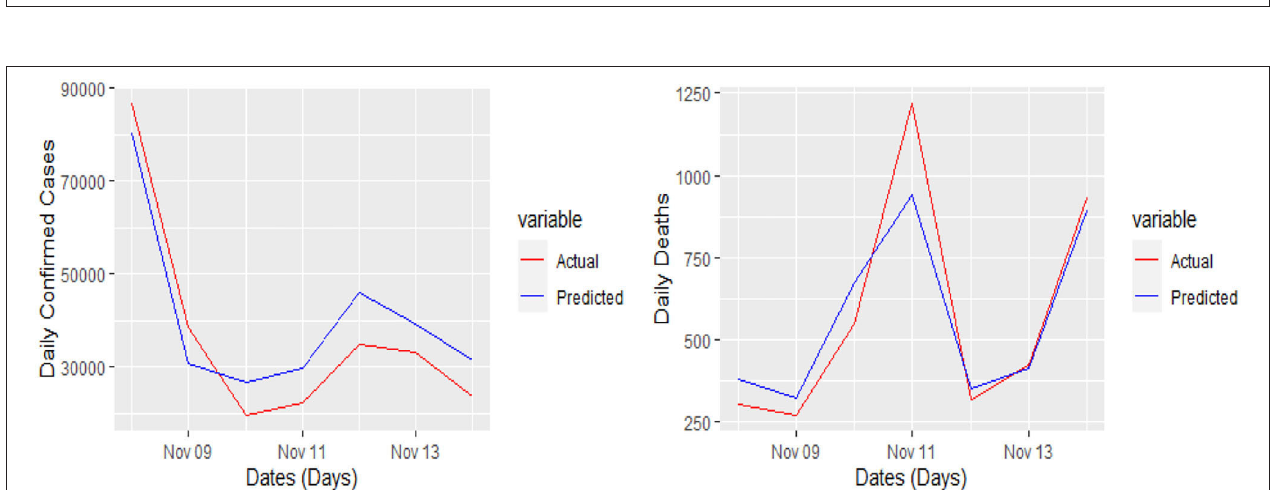
FIGURE 5 | Actual and predicted 7 days daily confirmed cases and deaths for Italy from COVID-19.